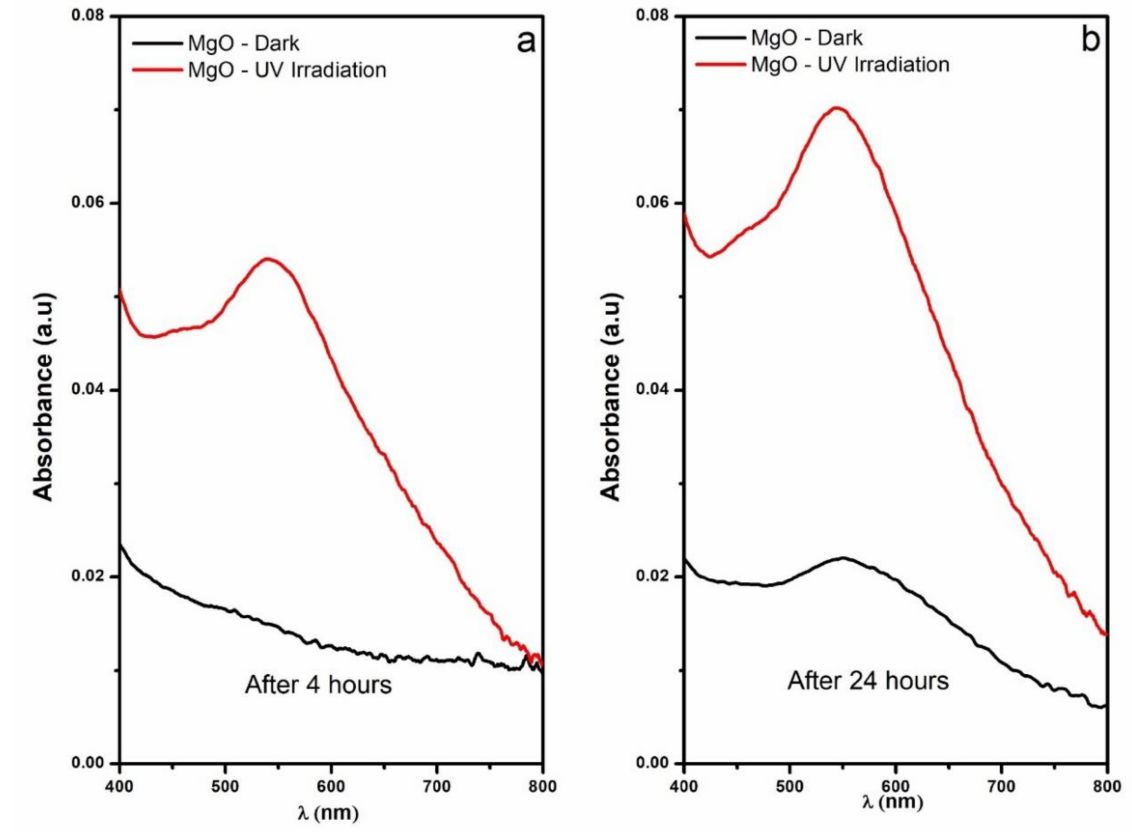
Figure 9. UV–Vis absorbance spectra of the iodine–starch complex used to quantify the H 2 O 2 production by the MgO NPs under irradiation UV and dark conditions; ( a ) 4 h and ( b ) 24